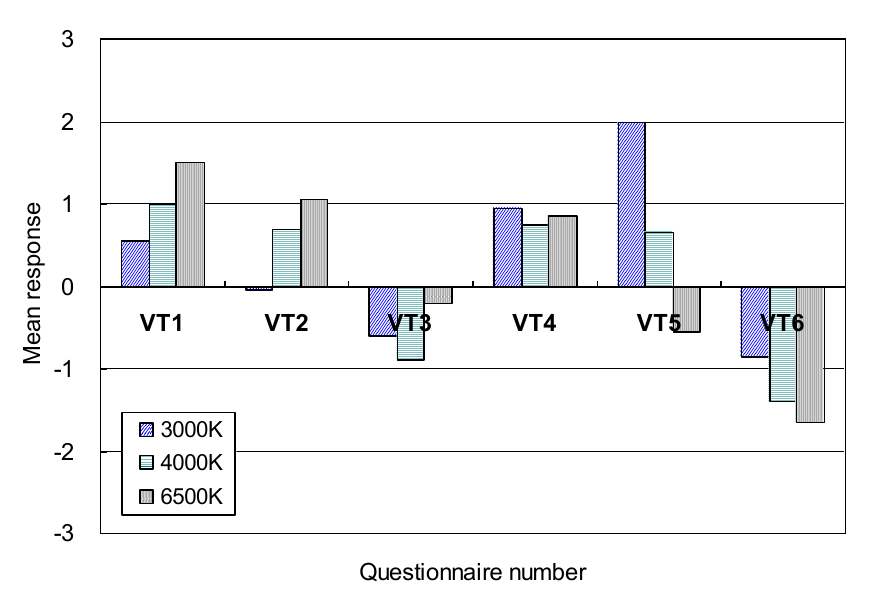
Figure 18. Perception of visual stimulation (500 lx condition, Paper task).